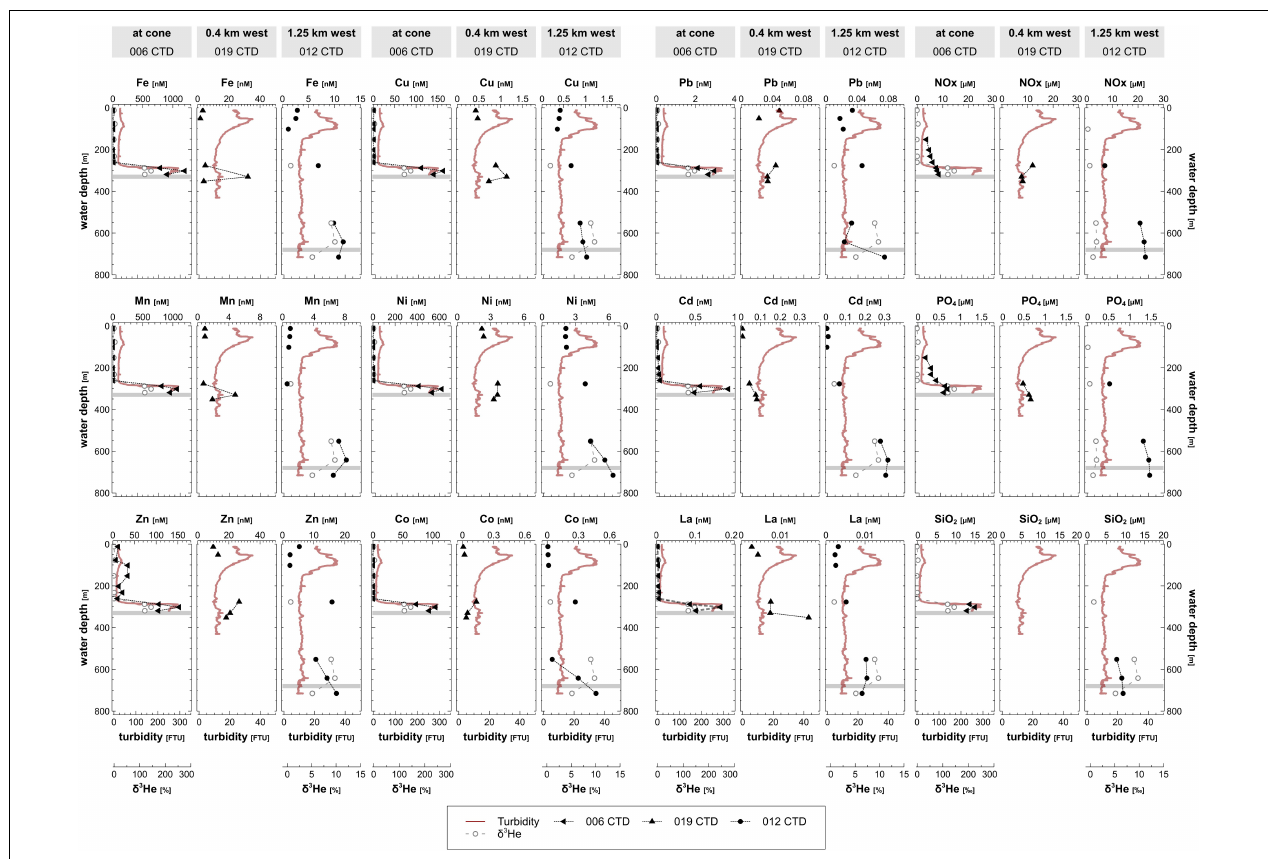
FIGURE 6 | Dissolved metal concentrations of Fe, Mn, Zn, Cu, Ni, Co, Pb, Cd, and La, as well as macronutrient concentrations NO x , PO 4 , and SiO 2 from three CTD casts at Macauley. Also shown are δ 3 He and turbidity data. No δ 3 He data are available for CTD 019. Horizontal gray bars CTDs 006 and 012 indicate depths of the respective hydrothermal vent sources (Kleint et al.,